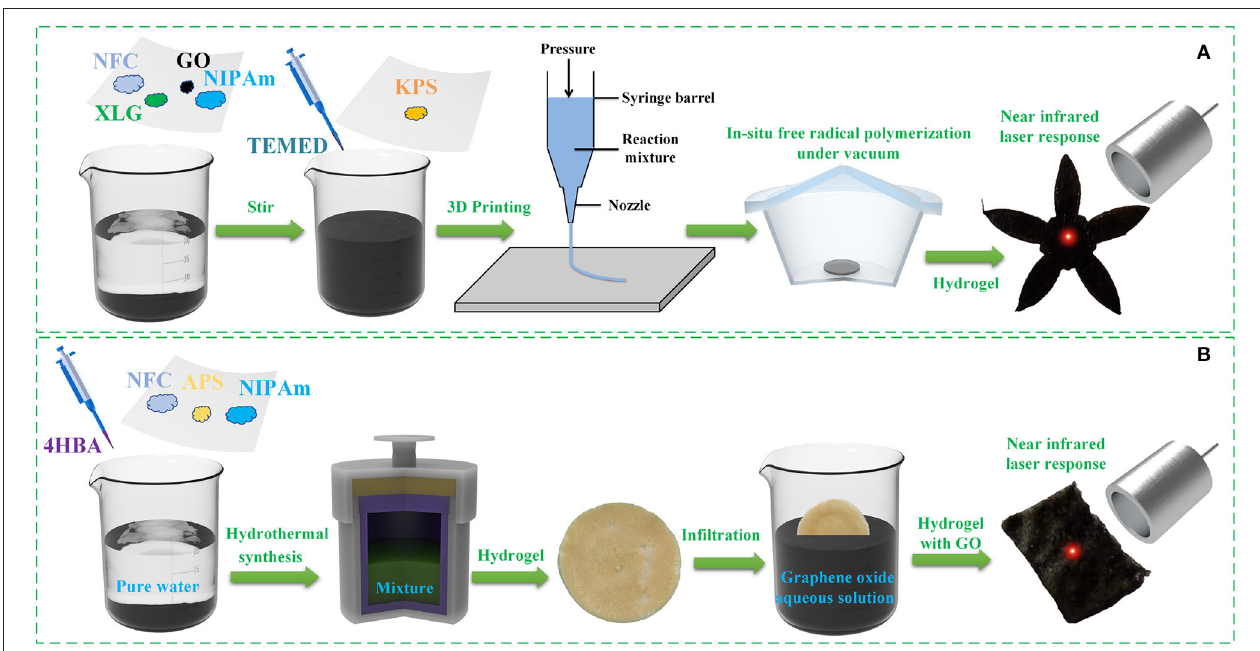
FIGURE 1 | Preparation schematic diagram of the (A) three-dimensional (3D) printed and (B) hydrothermal synthesized intelligent hydrogels with graphene oxide